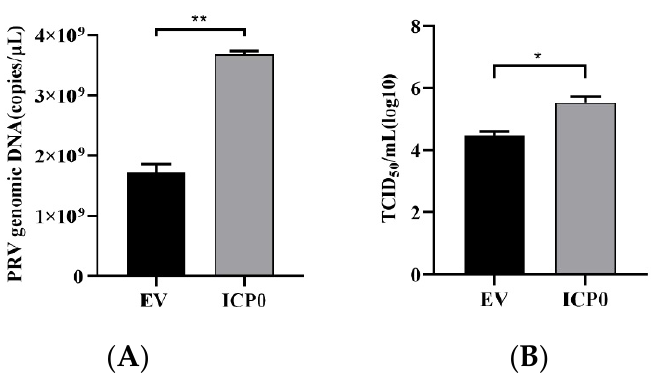
Figure 1. Exogenous expression of ICP0 enhances PRV replication in vitro. PK15 cells were trans- fected with 1 µ g pCMV-Myc plasmid (empty vector, EV) or pCMV-Myc-ICP0 plasmid (ICP0) for 24 h. Then, cells were infected with 0.01 MOI PRV for 24 h before PRV viral copy numbers and titers were measured. Real-time quantitative PCR was used to determine viral copy number ( A ), and